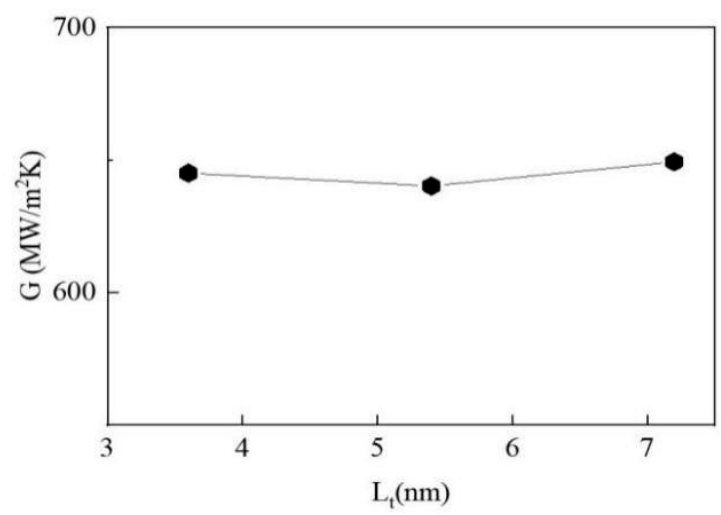
Figure 6. Effect of Cu-bulk thickness on TBC.